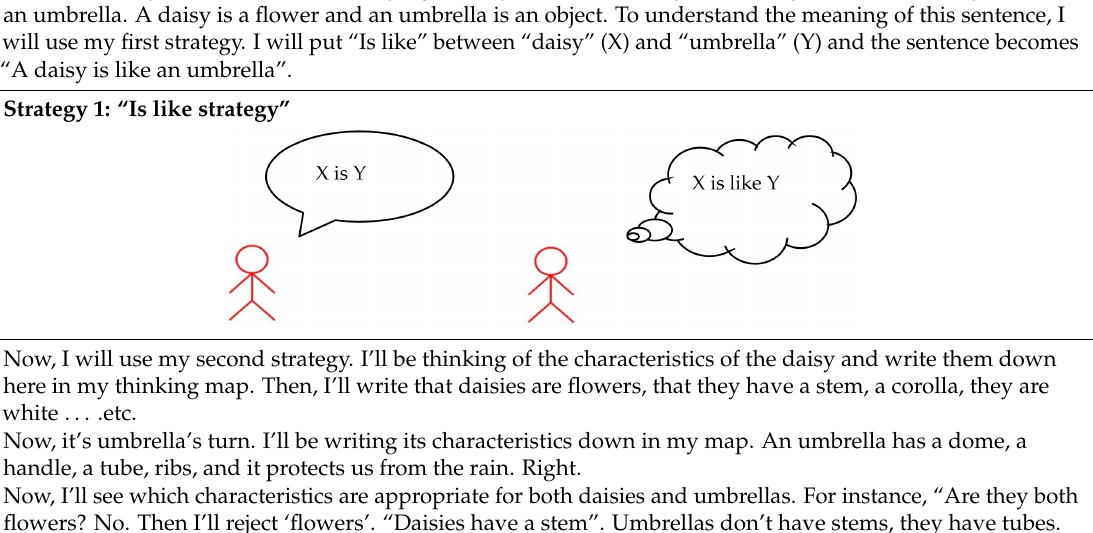
Table 2. Examples of activities with strategy 1 (“X is like Y heuristic”), and 2 (Comparative strategy). Example of modelling